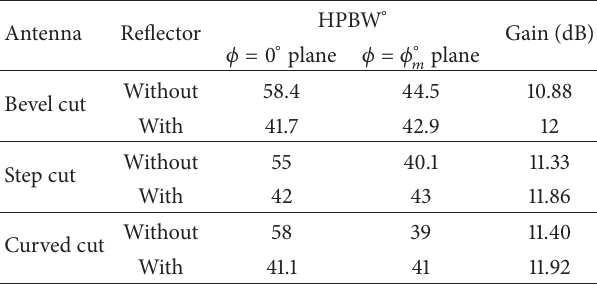
Table 3: Comparison of the radiation characteristics of the three designed antennas, with and without having the enhanced suitable reflector computed using CST.